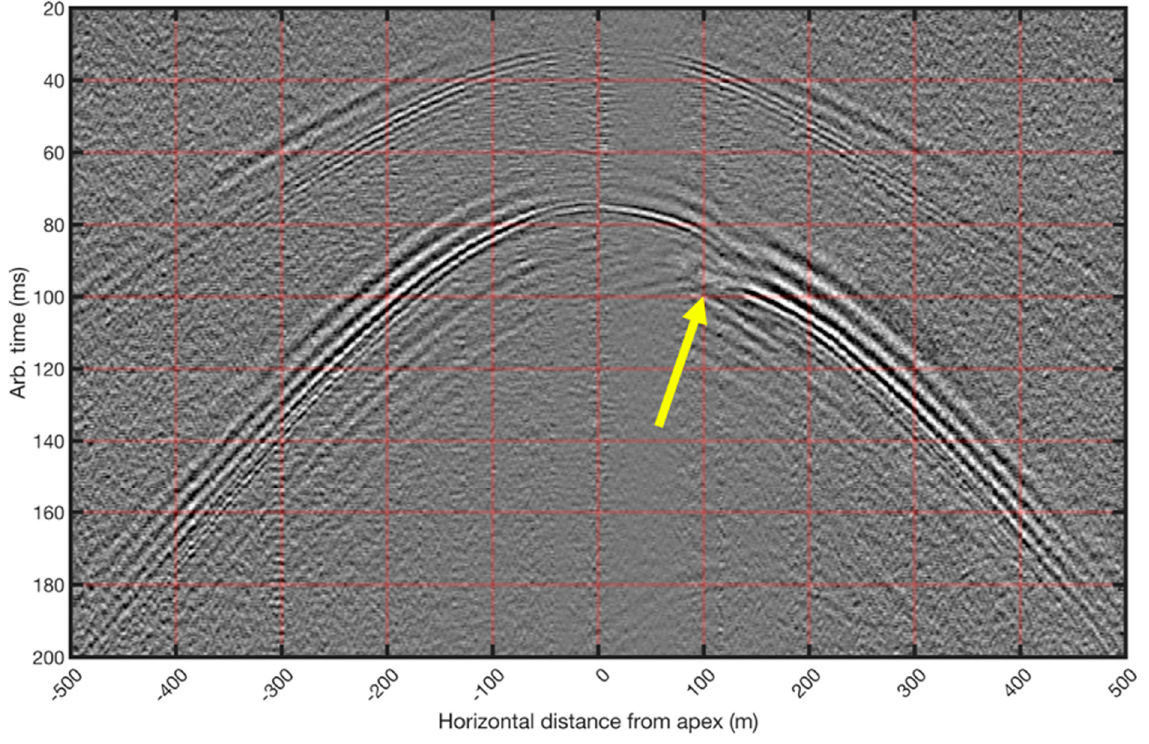
Figure 13. Guided waves and their interaction with fractures. Two sets of arrivals, both dispersive, can be observed. A clear imprint (yellow arrow) from open fractures can be seen on the slower guided S-waves. Figure adapted from Lellouch et al. (2020), Geophysics.